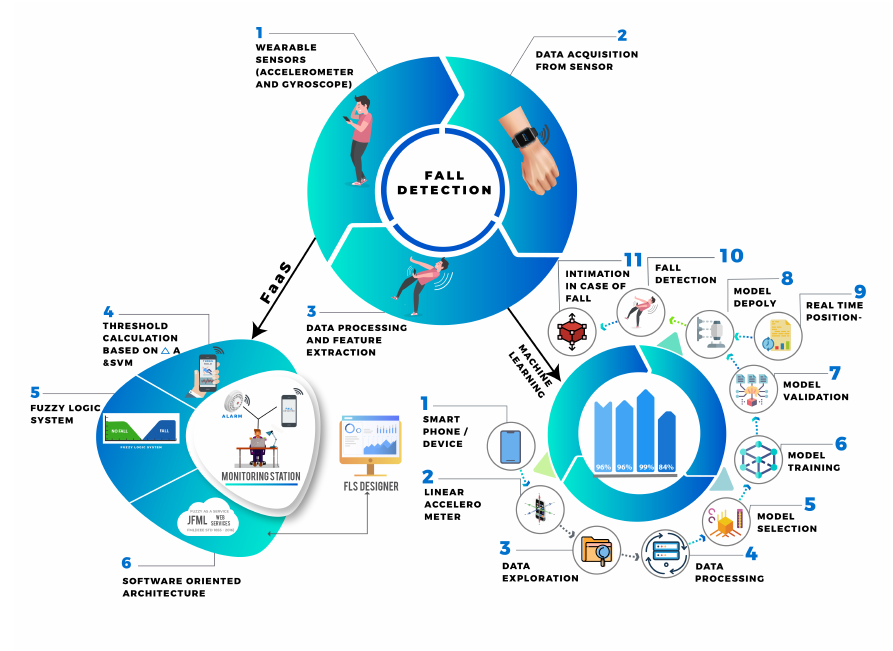
Figure 1. System architecture of a fall detection